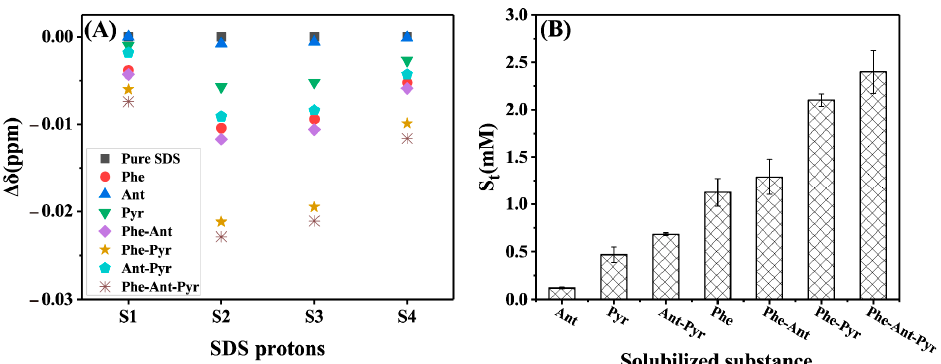
Figure 9. Chemical shift variations of SDS protons ( A ) compared to those of pure SDS and the total solubility ( B ) in different solubilization systems at the same SDS concentration of 120 mM.